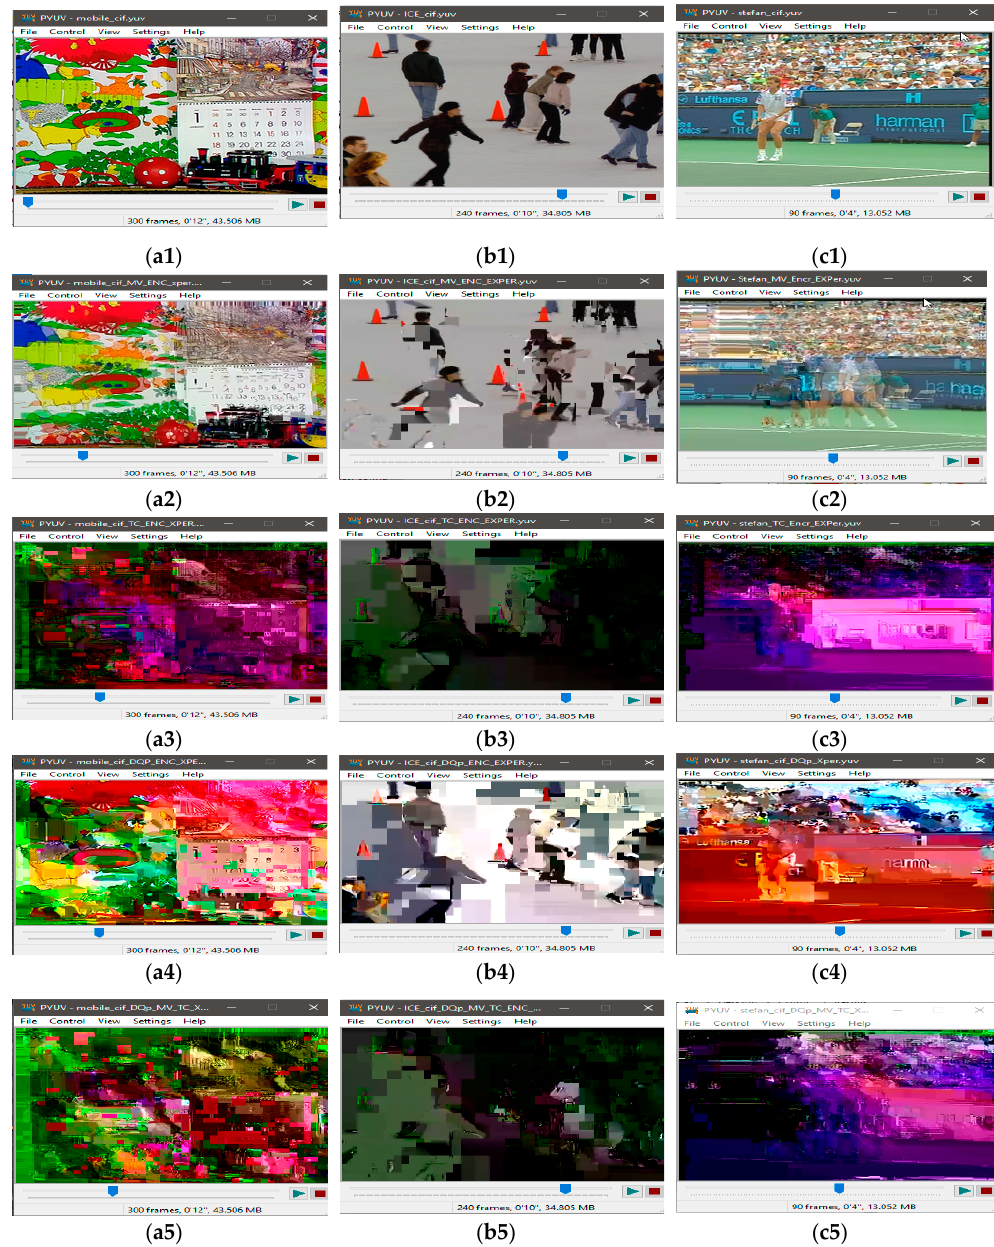
Figure 5. Visual protection of tested videos with EXPer encryption on selected syntax elements.